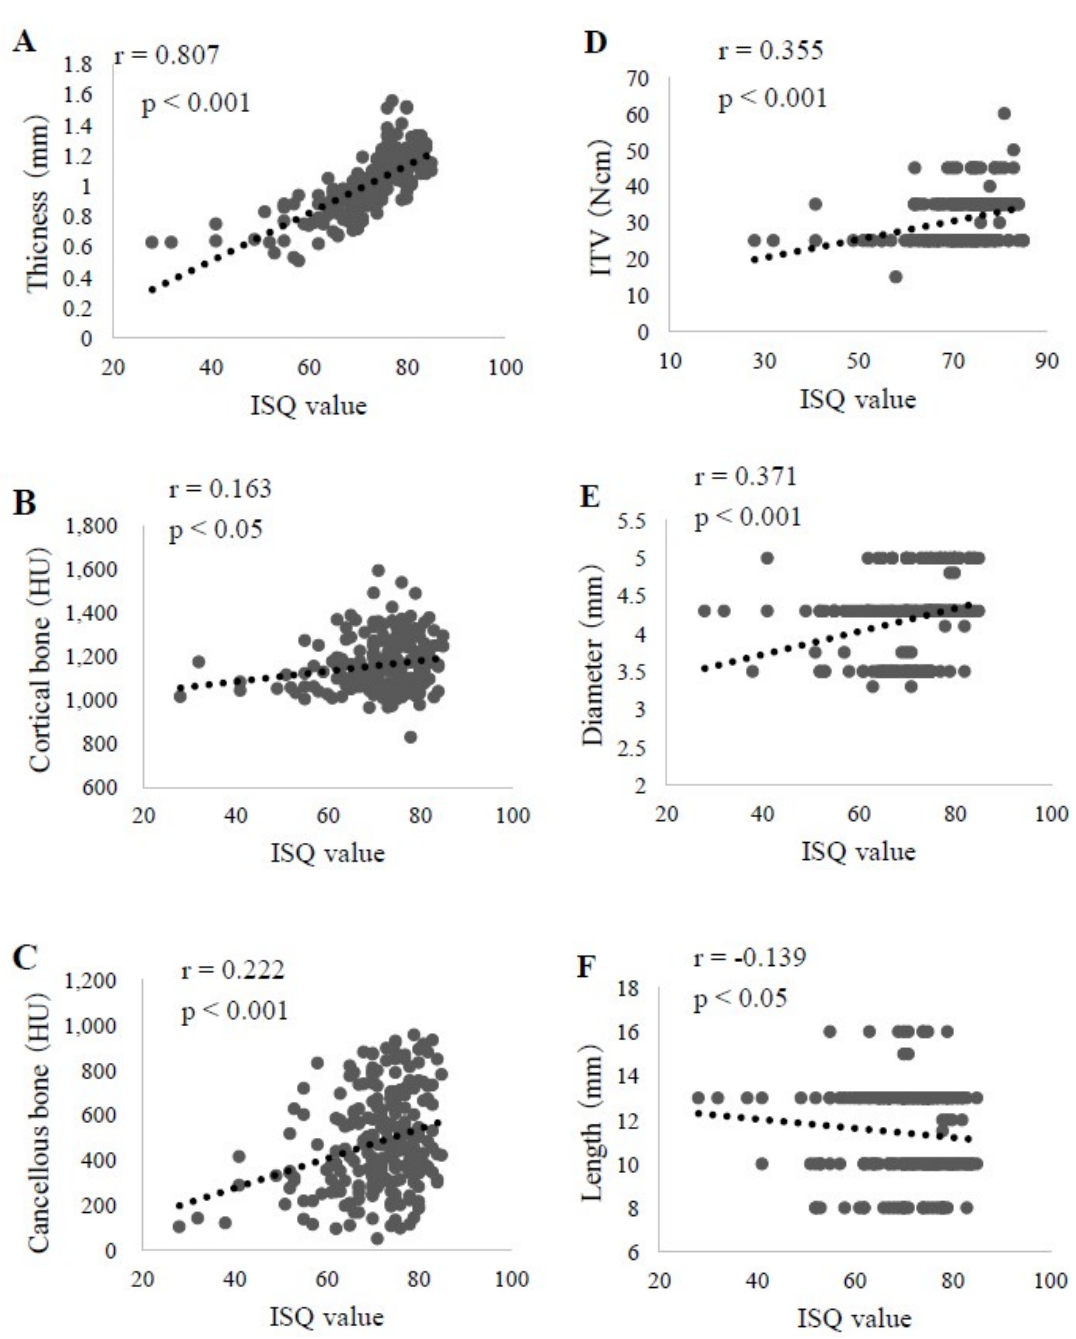
Figure 3. Correlation of each examined factor with the implant stability quotient (ISQ) value in all subjects (n = 247). A . Cortical bone thickness. B . Cortical bone CT value. C . Cancellous bone CT value. D . Insertion torque value (ITV). E . Implant diameter. F . Implant length.